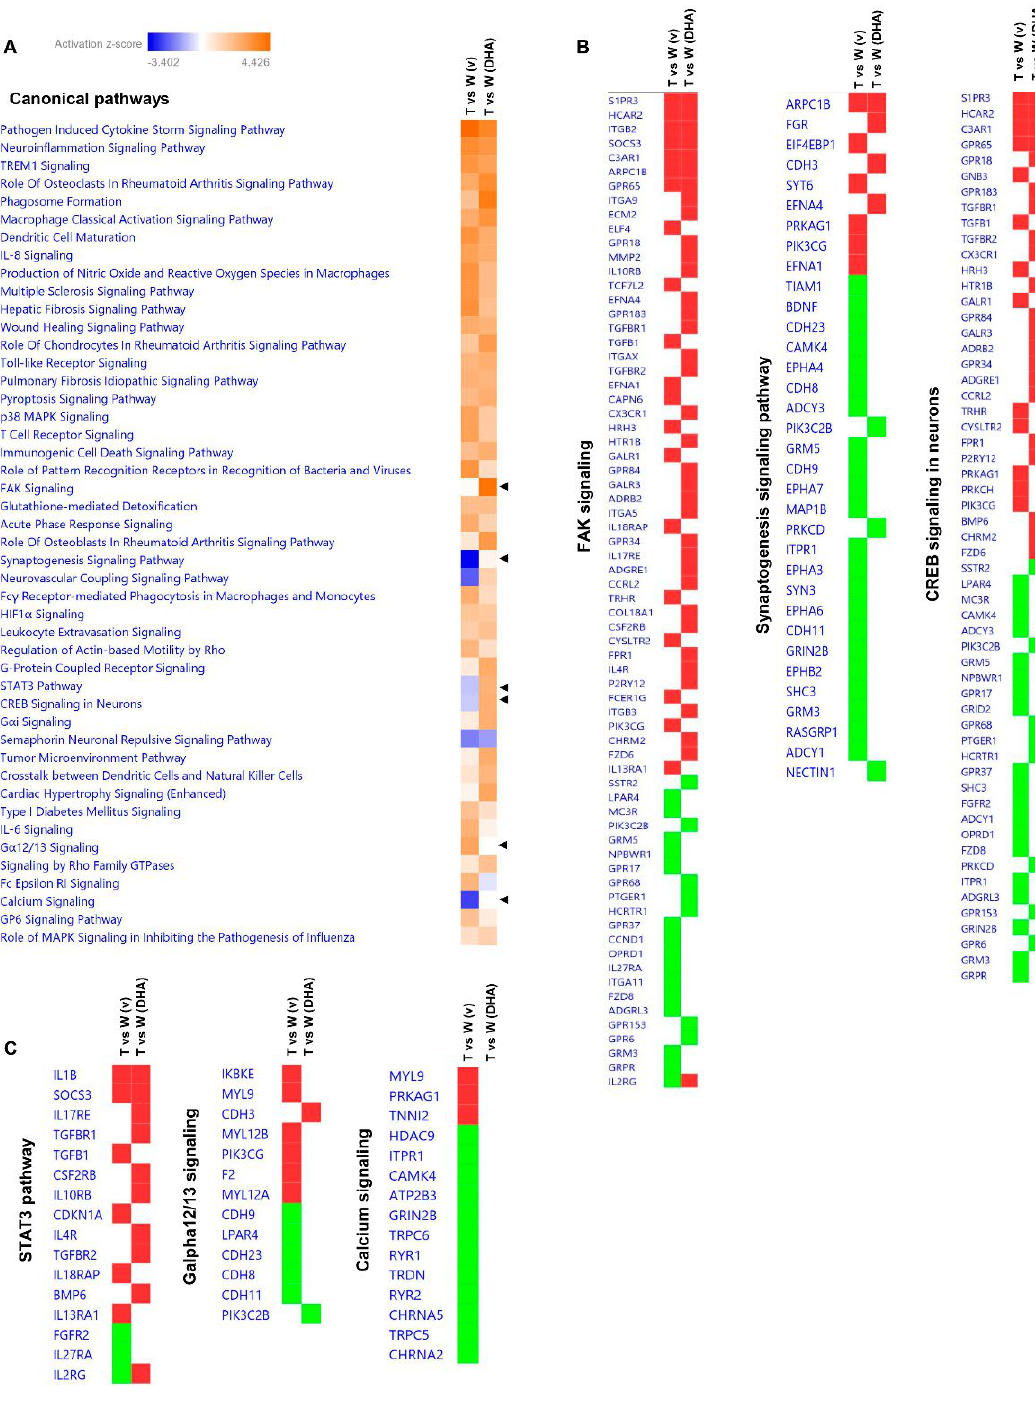
Figure 4. Predictive activation profile of pathways upon DHA treatment. Based on transcriptomic datasets, systems biology analyses were performed using IPA software to obtain the activation prediction of significantly altered pathways ( A ). The activation z-score was calculated as previously described with IPA. Blue and orange squares indicate inhibition and activation directionality, re- spectively. Black triangles refer to specific processes with an activation score associated with DHA treatment ( B , C ). T: Tg2576, W: wildtype, v: vehicle. Red: up-regulation; green: down-regulation.